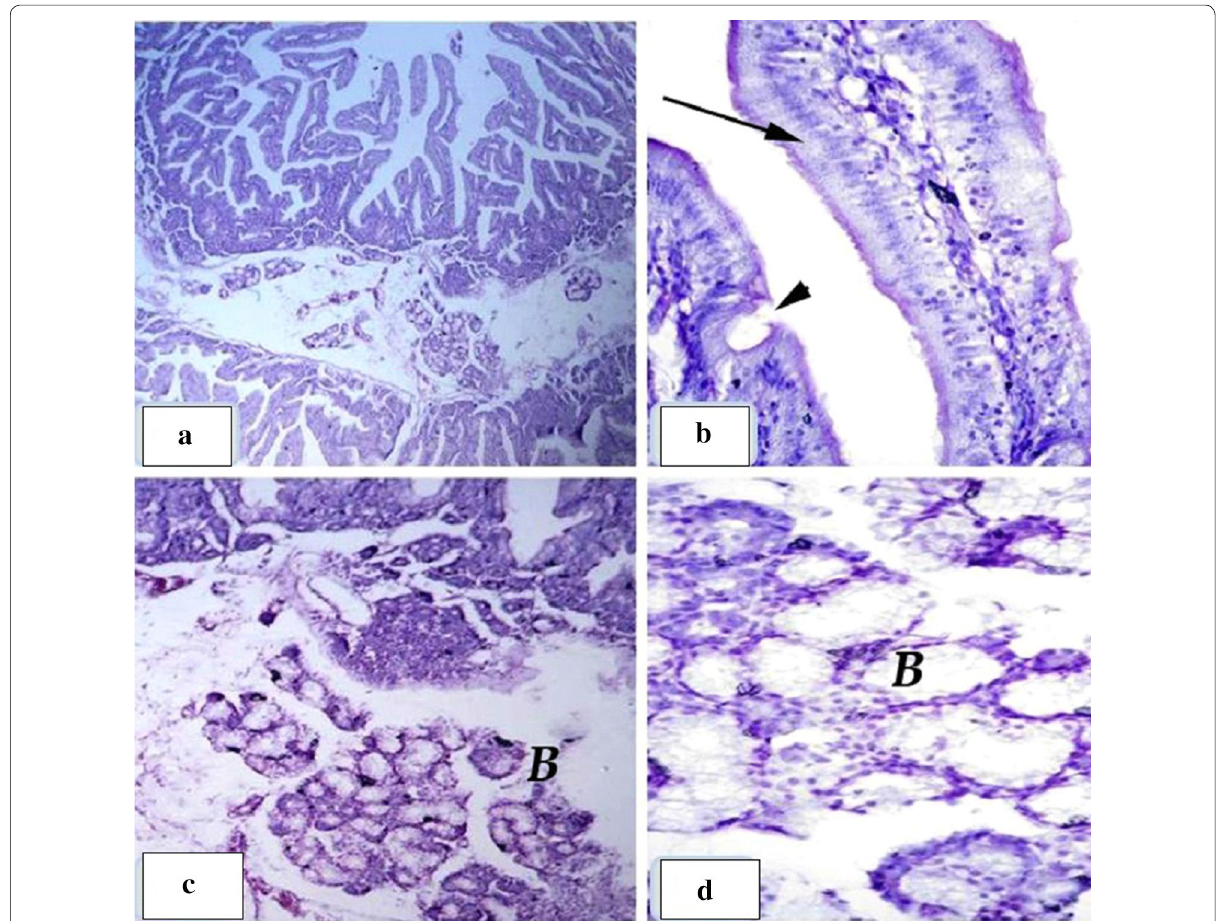
Fig. 2 Group T4: a showing normal duodenum wall. b Normal covering epithelium of columnar absorptive (arrow) and goblet cells (arrow head). c , d Normal brunners gland